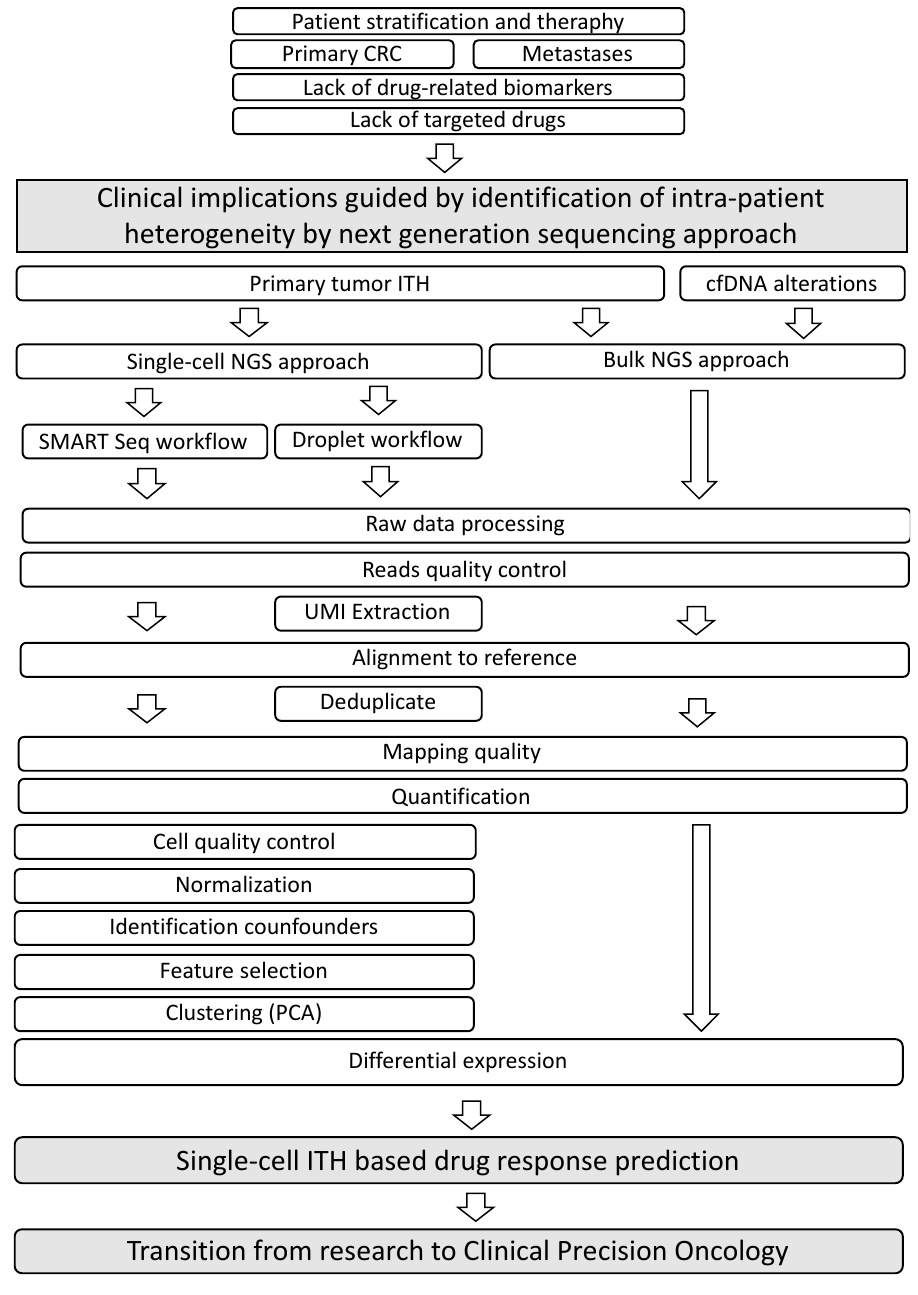
Figure 1. Brief outline of the state of the art of colorectal cancer management, issues to be addressed and potential solutions proposed by recent technologies for exploring genome and transcriptome alterations by mass and single-cell sequencing.